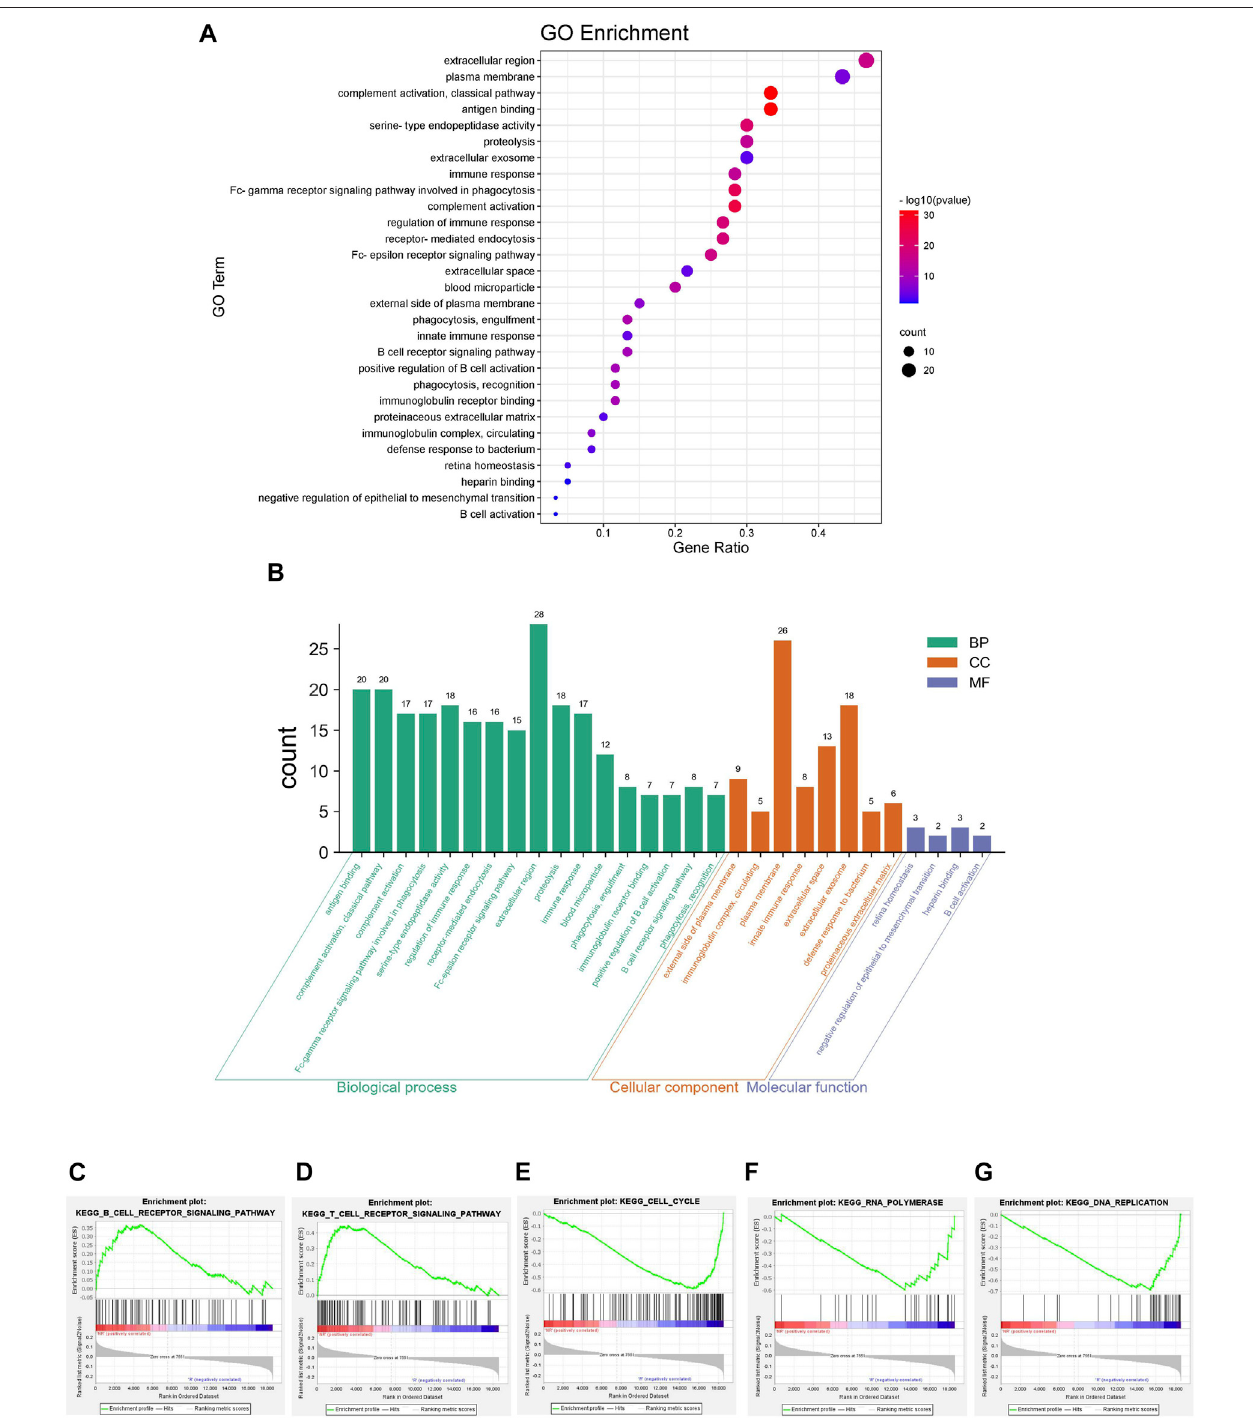
FIGURE2| FunctionalenrichmentformRNAsco-expressed (A) Thebubblepattern showstheenrichment pathways withGeneRatio, genecountand p -value (B) The histogram shows the enrichment of molecular function, biological process and cellular component. Results of GSEA enrichment on (C) B cell receptor signaling pathway (D) T cell receptor signaling pathway (E) Cell cycle (F) RNA polymerase, and (G) DNA replication.